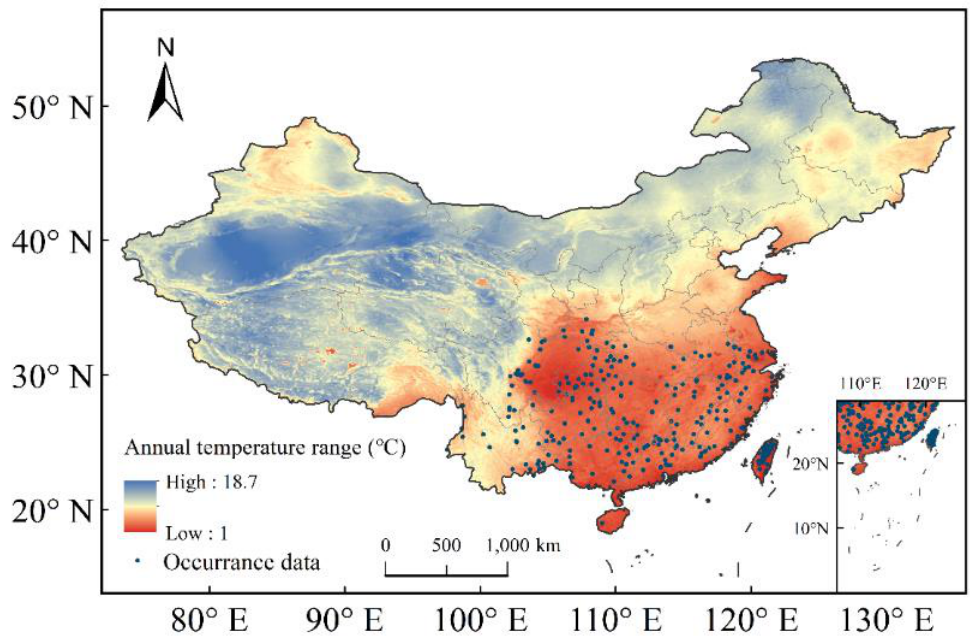
Figure 1. Distribution records of C. lanceolata in China and Taiwan province with annual tempera- ture range.